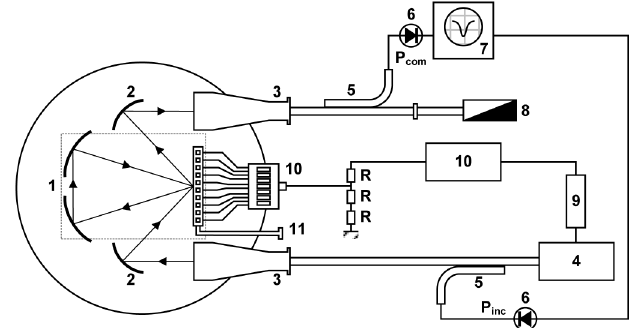
FIG. 7. Scheme of experimental setup of quasioptical micro- wave compressor with a diffraction grating: 1—three-mirror cavity, 2—focusing mirror, 3—input and output horns, 4— magnicon, 5—directional coupler, 6—detector, 7—oscilloscope, 8—load, 9—delay line, 10—high-voltage pulse generator and cutoff resistor unit, 11—diffraction grating evacuation unit.